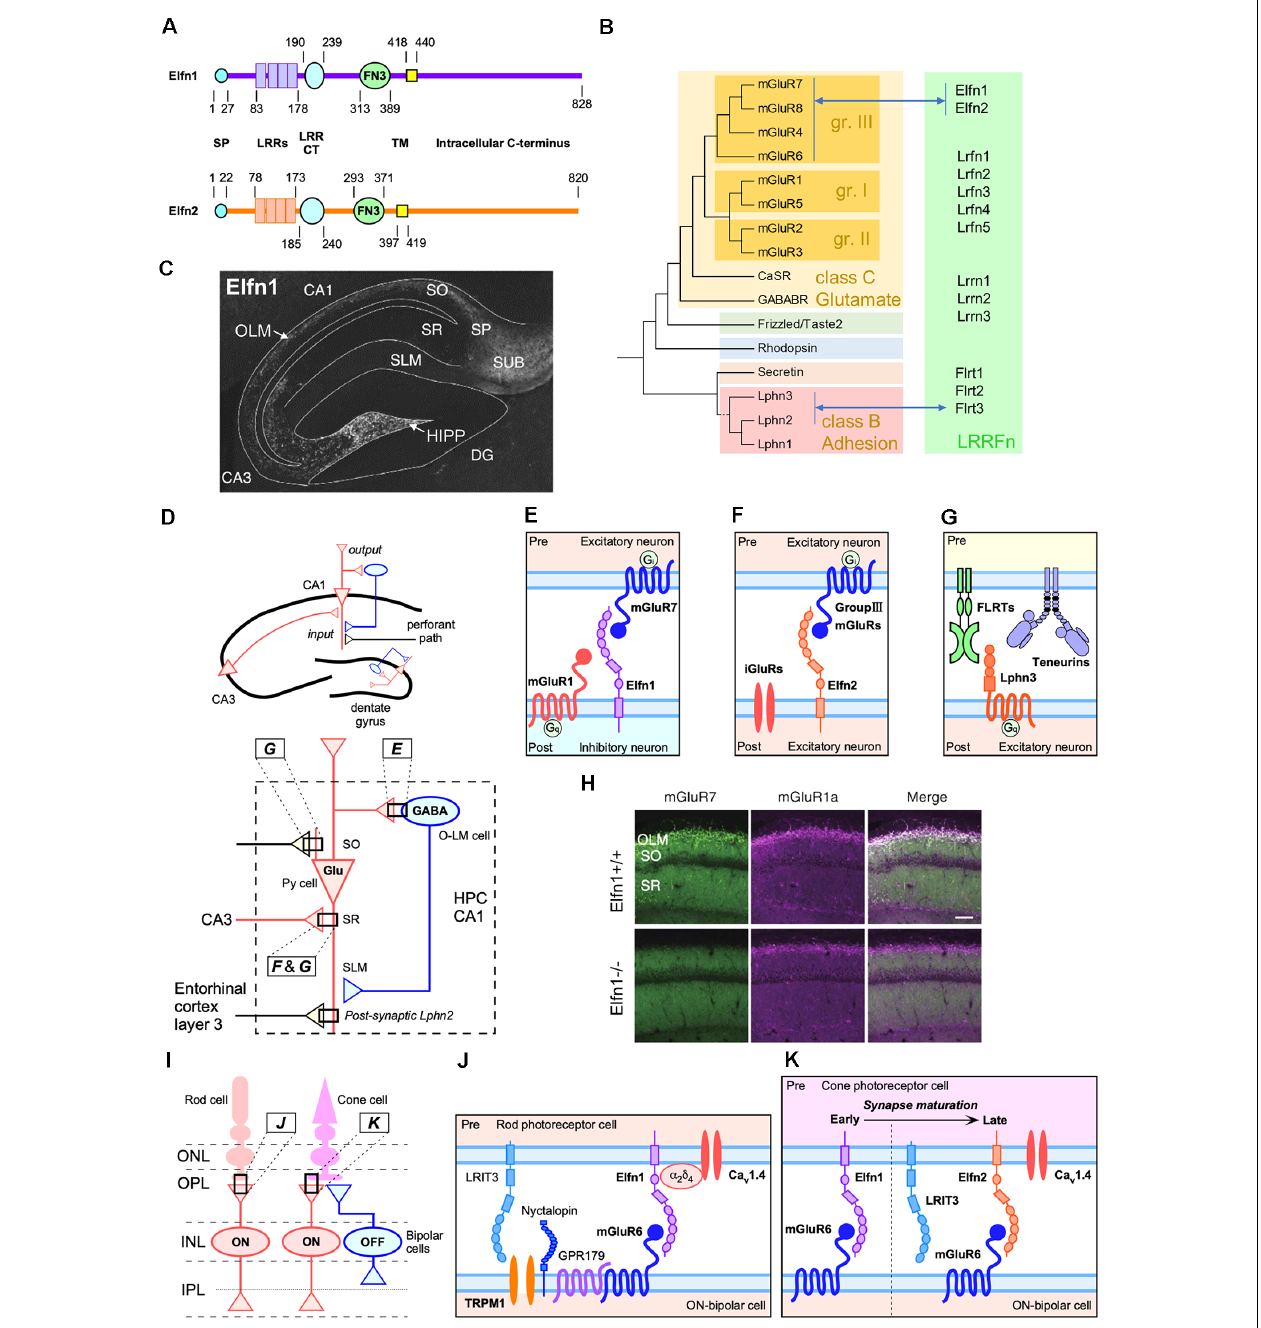
FIGURE 1 | Trans -synaptic interactions between leucine-rich-repeat (LRR) and fibronectin type III domain-containing transmembrane proteins (LRRFn) and metabotropic glutamate receptor (mGluR) proteins in the hippocampal CA1 circuits and function of extracellular leucine-rich repeat fibronectin domain-containing family proteins (Elfn1) in the retinal synapses. (A) Domain structure of Elfn1 and Elfn2. (B) Molecular phylogenetic tree of G protein-coupled receptor (GPCR; simplified tree from Fredriksson et al., 2003) and physical interaction between GPCR and LRRFn. (C) Distribution of Elfn1 protein in the hippocampus (reprinted from Tomioka et al., 2014). DG, dentate gyrus; HIPP, hilar perforant path-associated; OLM, oriens-lacunosum-molecule cells; SO, stratum oriens; SP, stratum pyramidale, SR, stratum radiatum; SLM, stratum lacunosum moleculare; SUB, hippocampal subiculum. (D) Two major inputs in CA1 and feedback inhibition by Elfn1-expressing interneurons (INs). Ipsi- and contra-lateral CA3 region inputs into dendritic domains of CA1 pyramidal neurons in the SR via Schaffer collaterals. The entorhinal cortex inputs into the SLM. Elfn1 is expressed in OLM cells and HIPP cells, which are GABAergic interneurons located in the SO of CA1 and the hilus of the dentate gyrus, respectively. Hippocampal CA1 circuits regulated by LRRFn–mGluR trans -synaptic interactions. (E) Trans -synaptic interactions of mGluR7 and Elfn1 formed between pyramidal cells and OLM cells. (F) Trans -synaptic interactions of Elfn2 with group III mGluR candidates such as mGluR4, mGluR7, and mGluR8 between